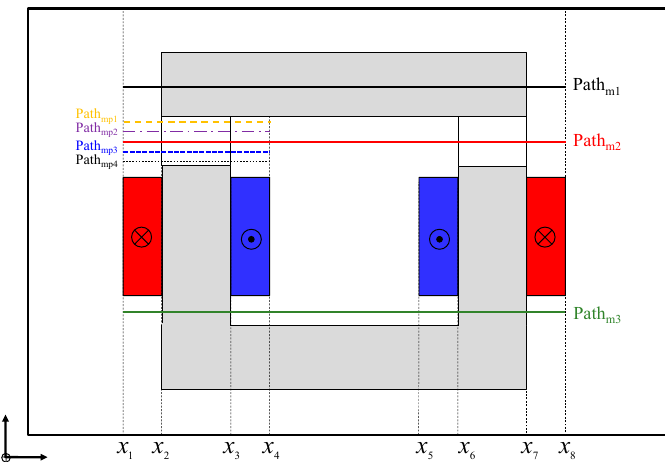
Figure 6. Paths of magnetic flux density validation for the comparison.